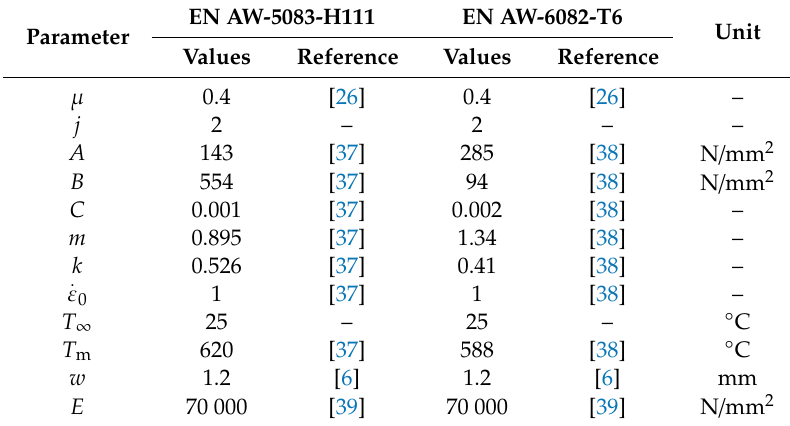
Table A1. Numerical values of the torque model parameters with units and the corresponding literature sources.